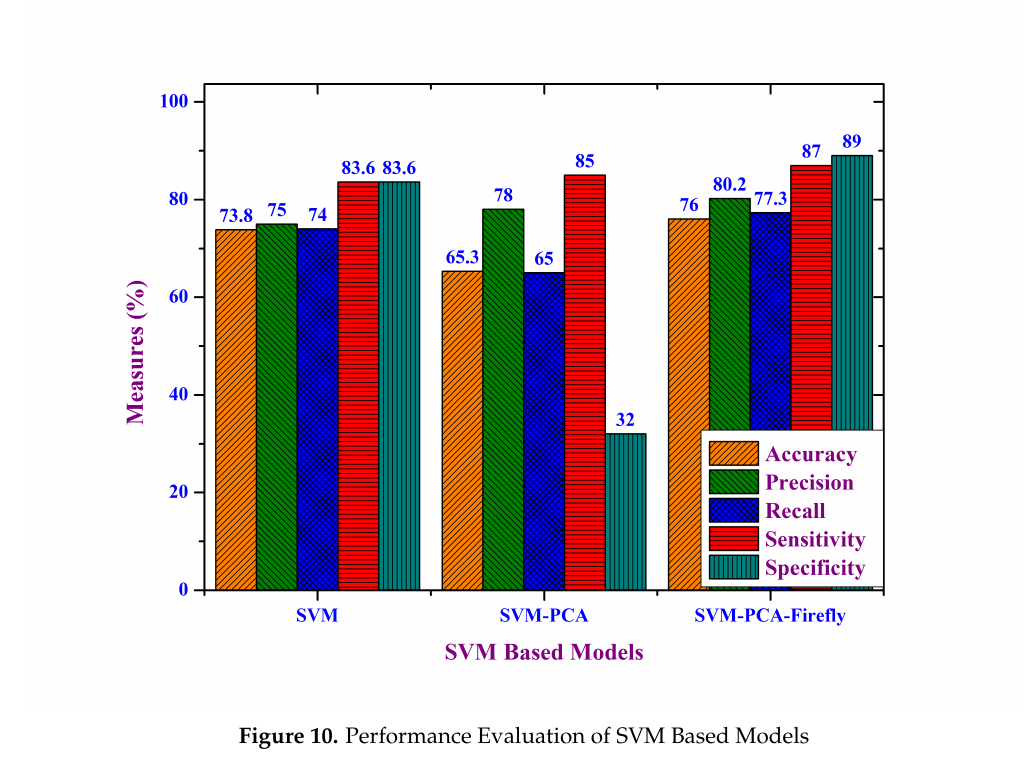
Figure 10. Performance Evaluation of SVM Based Models